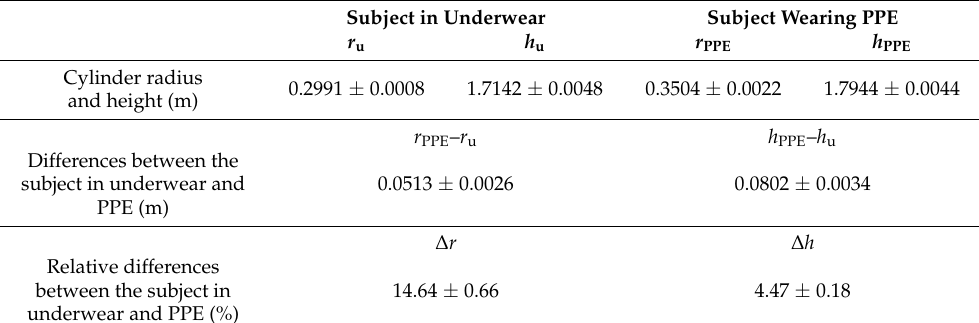
Table 2. Dimensions of the human silhouette circumscribed by a cylinder as well as absolute and relative differences between the subject in underwear and PPE.